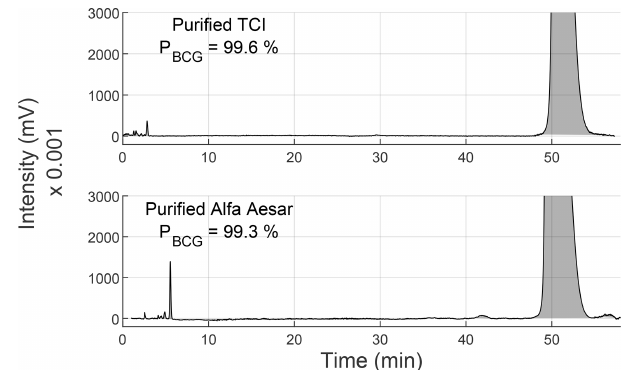
Figure 3. Analytical HPLC chromatograms of purified BCG from TCI and Alfa Aesar with their P BCG . All peaks are highlighted with gray background color.